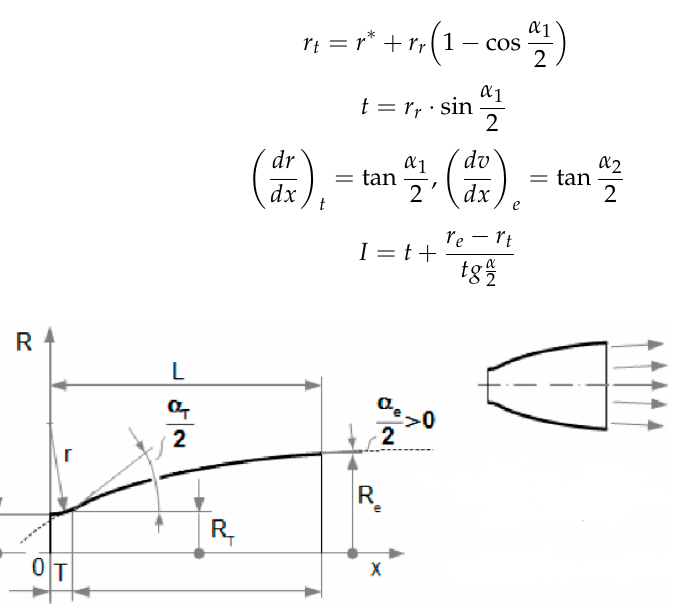
Figure 6. Laval nozzle—characteristic method. Reprinted from ref. [26].